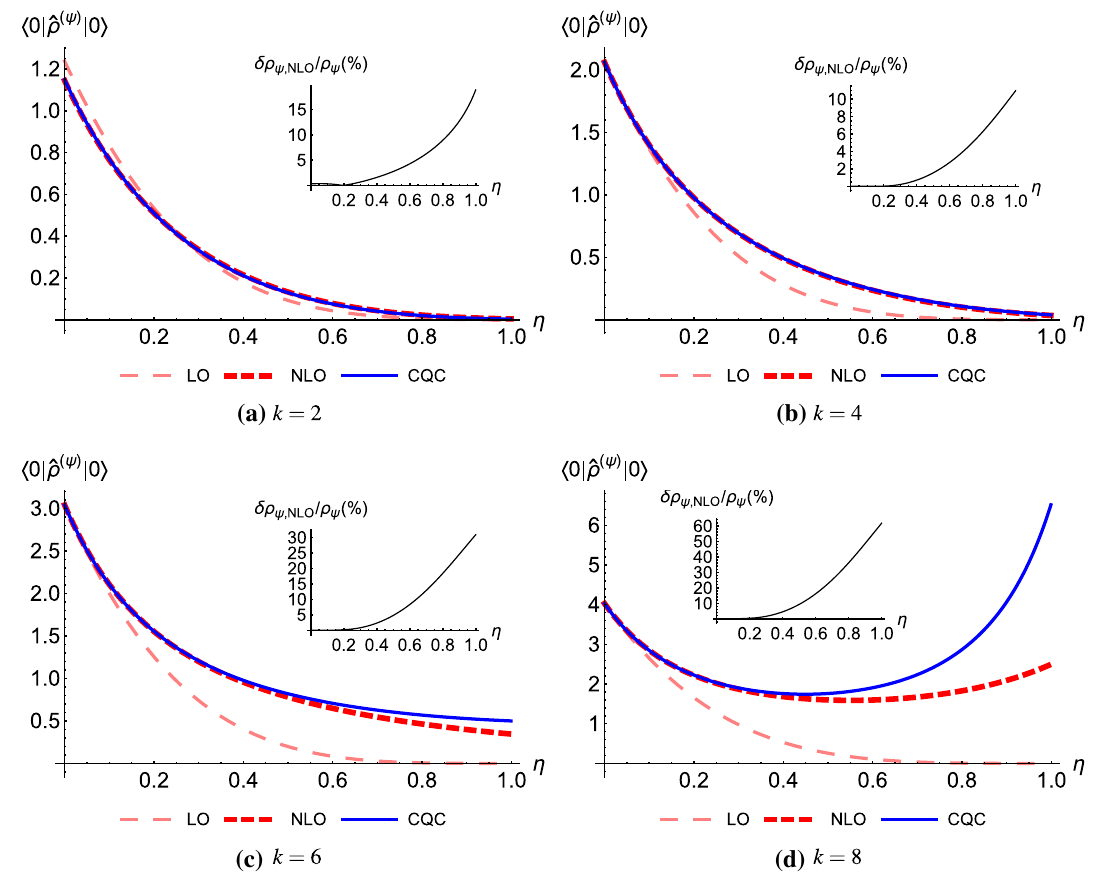
(cid:8) (cid:9) ρ ψ, − ρ ψ, | × 100%, as /ρ ψ, NLO CQC CQC